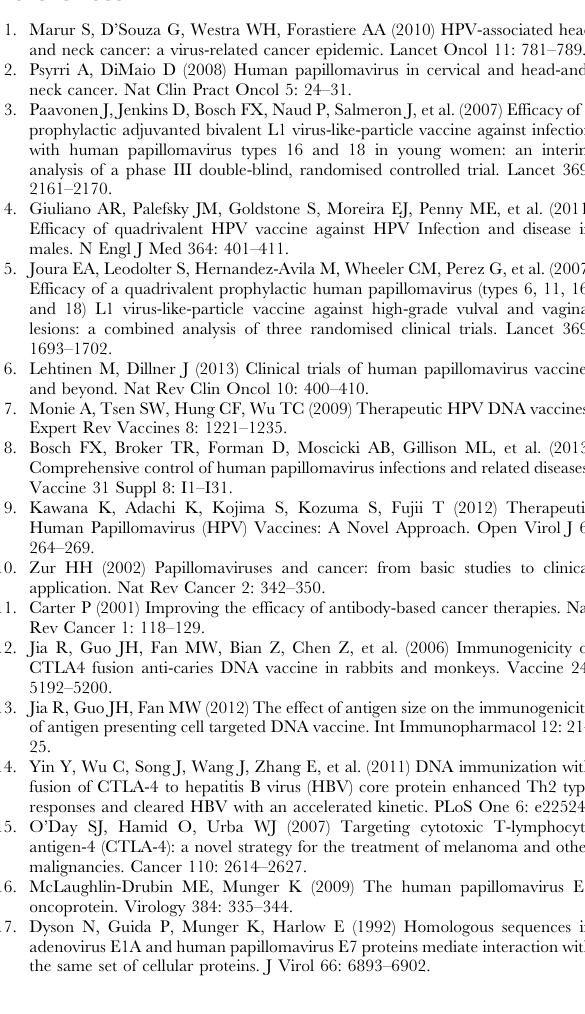
Figure S1 FACS analysis of the binding ability of CTLA- 4-E7E6 fusion protein to mouse dendritic cell DC2.4.